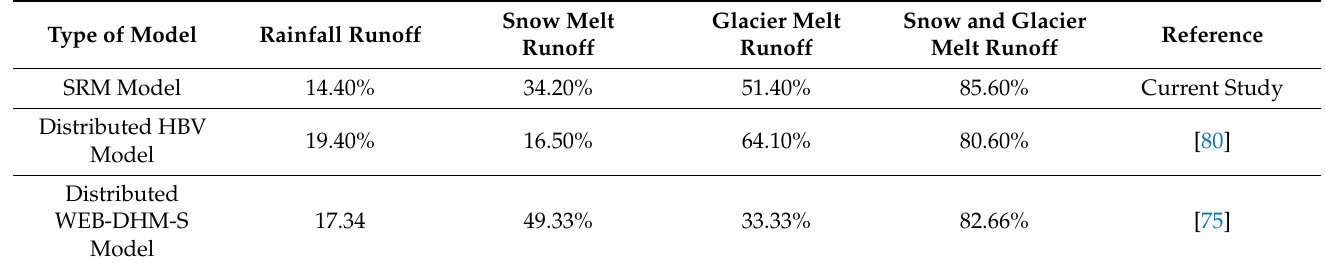
Table 4. Results comparison with similar studies in the Hunza